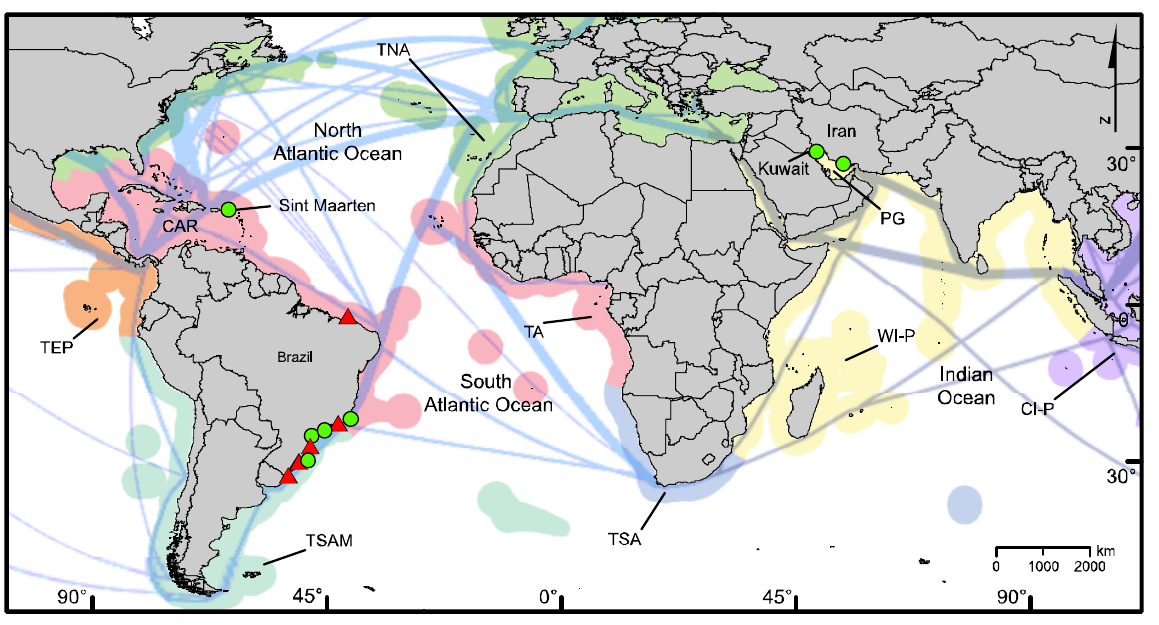
Figure 1. Distribution of Stragulum bicolor . Colour shades in the background represent different marine realms. TA = Tropical Atlantic; TNA = Temperate Northern Atlantic; TSAM = Temperate Southern America; TSA = Temperate Southern Africa; WI-P = Western Indo-Pacific; CI-P = Central Indo-Pacific; and TEP = Tropical Eastern Pacific. Green circles = locations of examined materials. Red triangles = literature records. PG = Persian Gulf; CAR = Caribbean Sea. The lines with different thicknesses represent major, medium, and minor worldwide shipping routes (Shipping data modified after [18]).